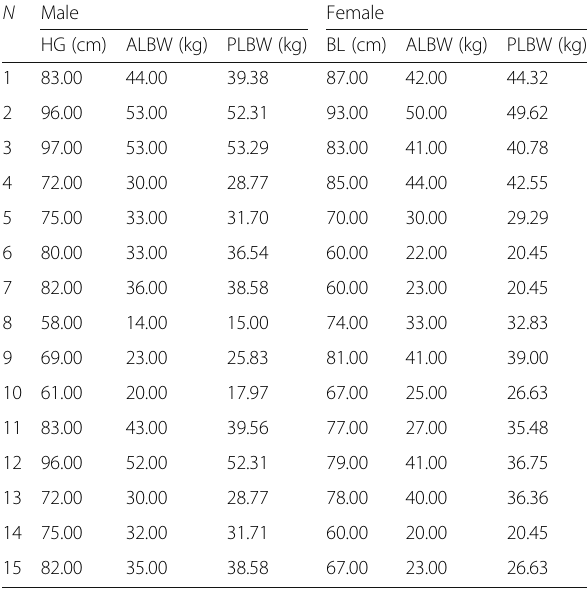
Table 4 Predicted live body weight (kg) of Shami goats given HG (cm) for male and BL (cm) for female